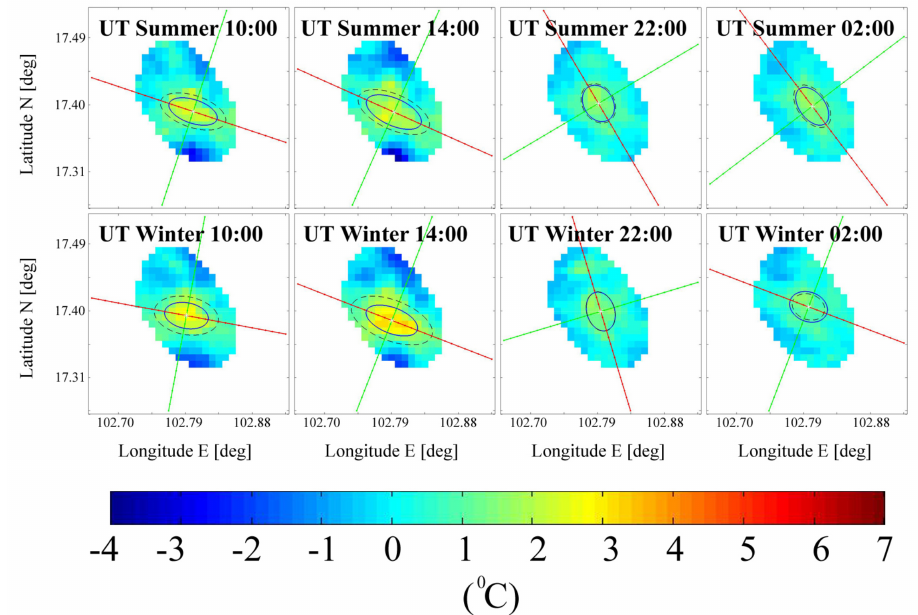
Figure 6. SUHI ( ◦ C) and Gaussian fitting during 2014 for Ubon Ratchathani (UR), Khon Kaen (KK), and Udon Thani (UT) for summer and winter, considering the diurnal variation at 10:00, 14:00, 22:00, and